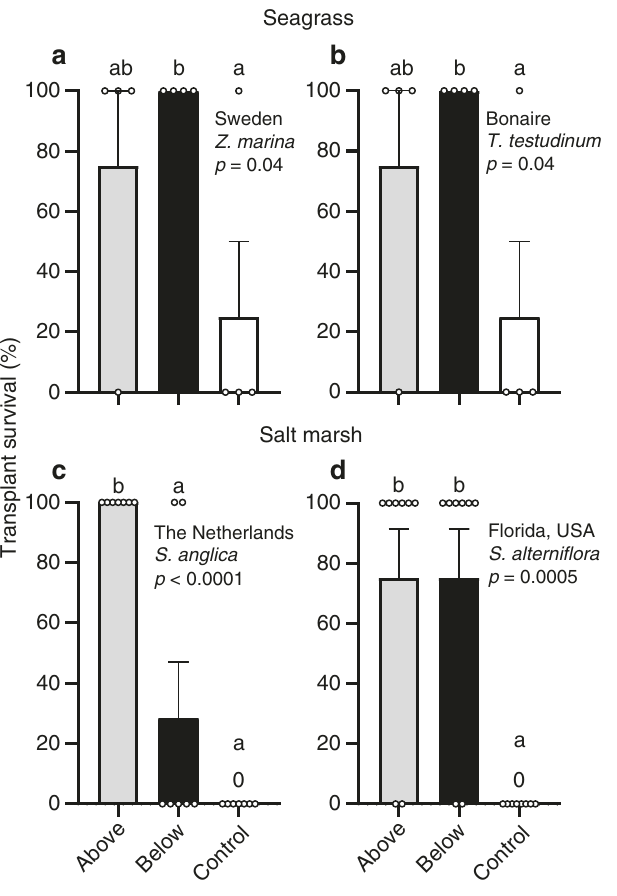
Fig. 2 Transplant survival. a , b Seagrass transplant survival in Sweden ( n = 4) and Bonaire ( n = 4) in above- (gray) and belowground structures (black), and controls (white). c , d Cordgrass transplant survival in the Netherlands ( n = 7) and Florida ( n = 8). Note that survival at both seagrass sites was identical. Data are presented as mean values + SEM. Exact p values are shown for treatment effects when p > 0.0001 (two sided). Signi fi cant contrasts are indicated by different letters ( p < 0.05,